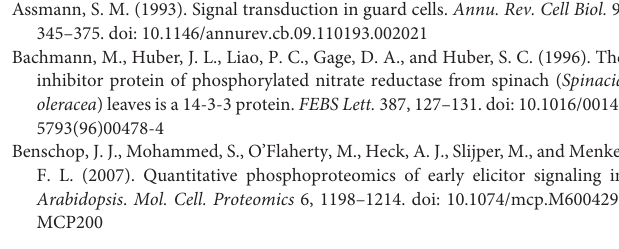
( Figure 4 ). For example, 14-3-3 χ preferentially forms hetero- dimers with phylogenetically similar 14-3-3 isoforms ( ω , ϕ , ψ , ν ) (Swatek et al., 2011). Collectively, these studies suggest a role of 14-3-3 proteins in storage reserve deposition during seed